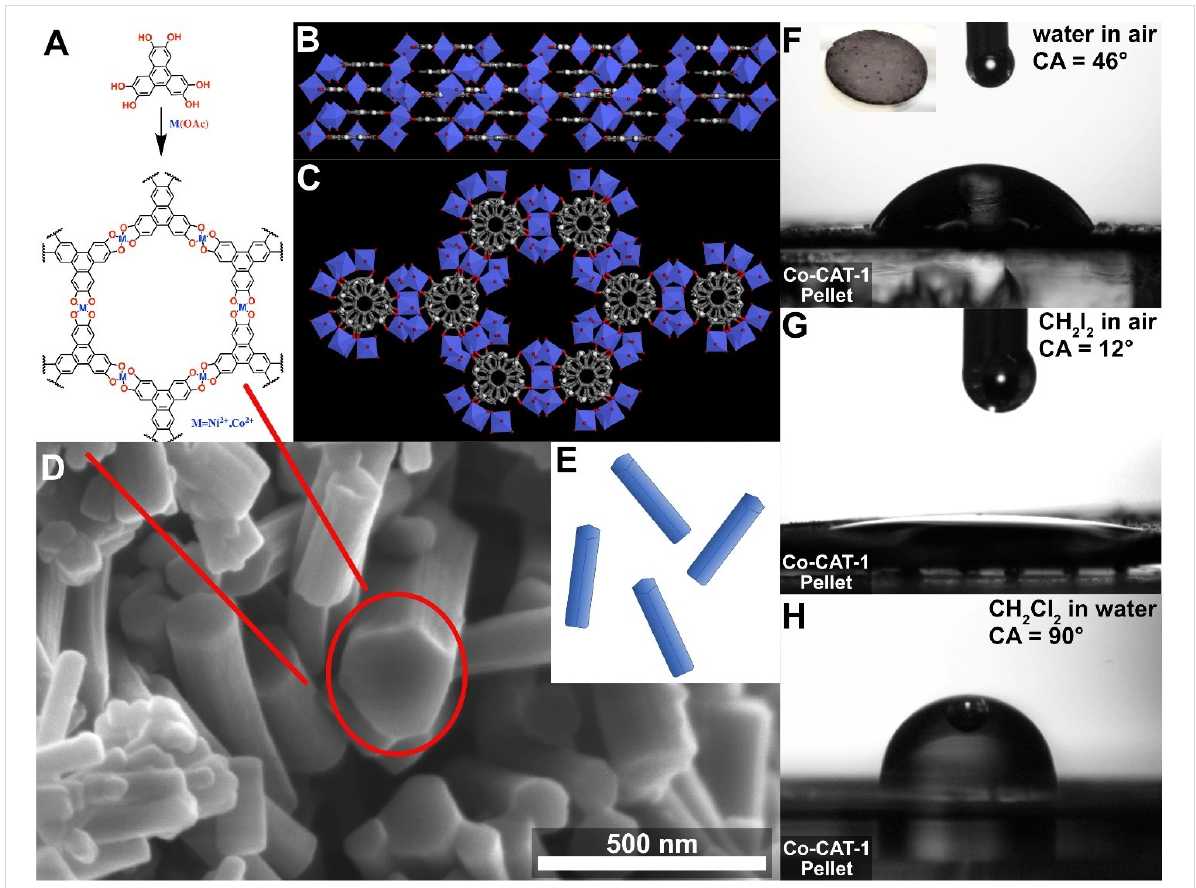
Figure 1: A) Synthesis scheme of M-CAT-1 using 2,3,6,7,10,11-hexahydroxytriphenylene (HHTP) and the respective metal acetate under solvother- mal conditions. B) Side view of the Co-CAT-1 crystal structure illustrating infinite layers of HHTP 2 Co 3 . C) View along the crystallographic c -axis high- lighting the hexagonal pore channels. D) SEM micrograph showing the needle-like crystallite morphology, which is sketched in E) as elongated hexag- onally shaped monoliths. F) Water contact angle (WCA) measured at the solid/air interface of a Co-CAT-1 pellet. G) Diiodomethane CA measured on the same pellet. H) Underwater CA measured at the solid/water interface on the identical pelletized sample.